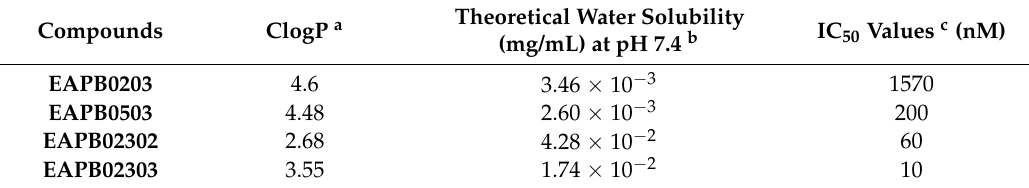
Table 3. First and second generation imiqualines leads: ClogP, theoretical water solubility (mg/mL)